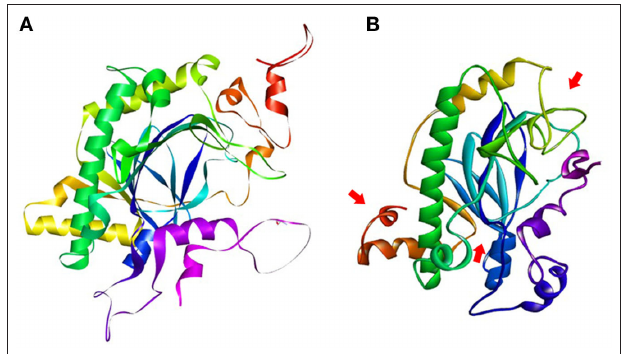
FIGURE 4 | Protein structure prediction for the OsGA20Ox2 gene. (A) IWP; (B) WP-22-2-loss of amino acids and structural changes is clearly visible in the mutant. The arrows indicate the visible structural changes and amino acid composition in the mutant WP-22-2.